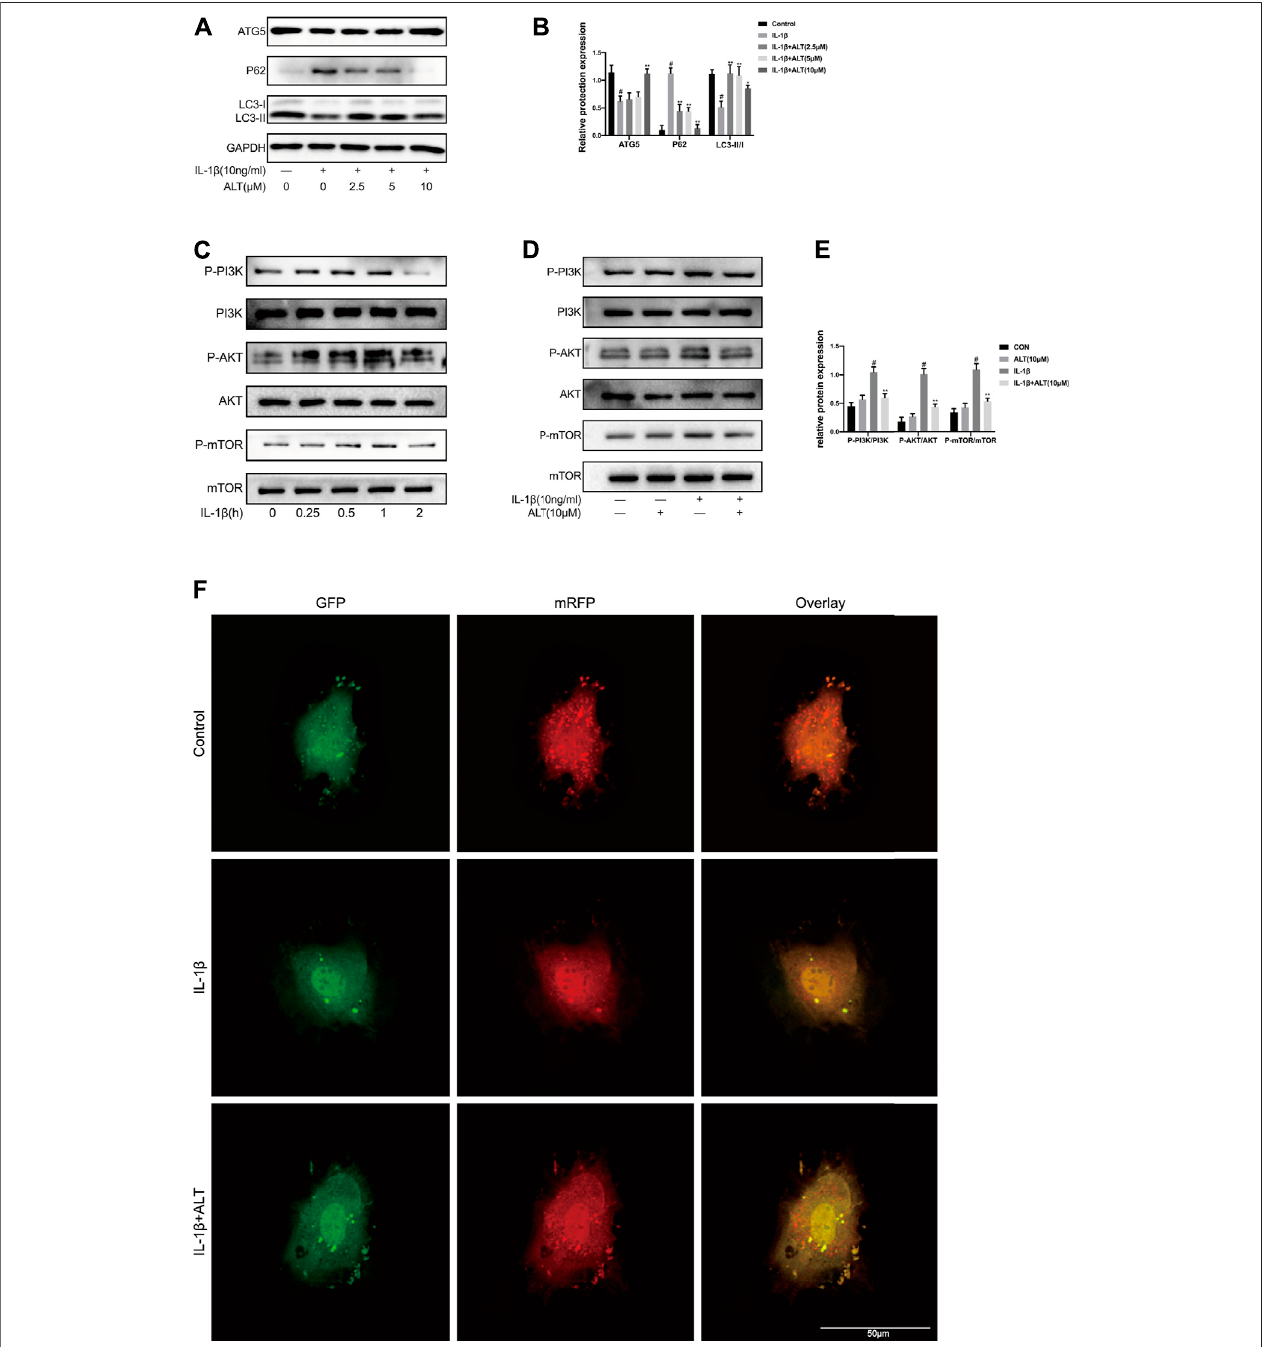
FIGURE5| ALTmitigated impairedautophagyinducedbyIL-1 β inmousechondrocytes.Cellswerestimulated byIL-1 β (10 ng/ml)withorwithoutALT(2.5,5,and 10 μ M) for 24 h. (A) Western blot was employed to detect the expression of ATG5, P62 and LC3 Ⅱ / Ⅰ . (B) Relative protein expression was quali fi ed by ImageJ software, GAPDHwasusedastheinternalcontrol,respectively( n (cid:2) 3). (C) Mousechondrocytes wereexposedtoIL-1 β (10 ng/ml)atdifferenttimepoints(0,0.25,0.5,1,and2 h). PI3K/AKT/mTOR-related signaling molecules was determined by Western blot. (D) Cells were exposed to ALT (10 μ M) with or without IL-1 β (10 ng/ml) for 1 h. ProteinlevelsofP-PI3K,PI3K,P-AKT,AKT,P-mTORandmTORweredetectedbyWesternblot. (E) Relativeproteinexpressionwasquali fi edbyImageJsoftware,PI3K, AKTandmTORwereusedastheloadingcontrol,respectively( n (cid:2) 3) (F) ChondrocytesweretransfectedwiththemRFP-GFP-LC3adenovirusfor24 handtreatedbyIL- 1 β (10 ng/ml)withorwithoutALT(10 μ M)for24 h.Autophagosomeswererepresentedbyyellowpunctaandautolysosomesbyredpunctainmergedimages.# p < 0.05 vs. control group; * p < 0.05 vs. IL-1 β group; ** p < 0.01 vs. IL-1 β group.